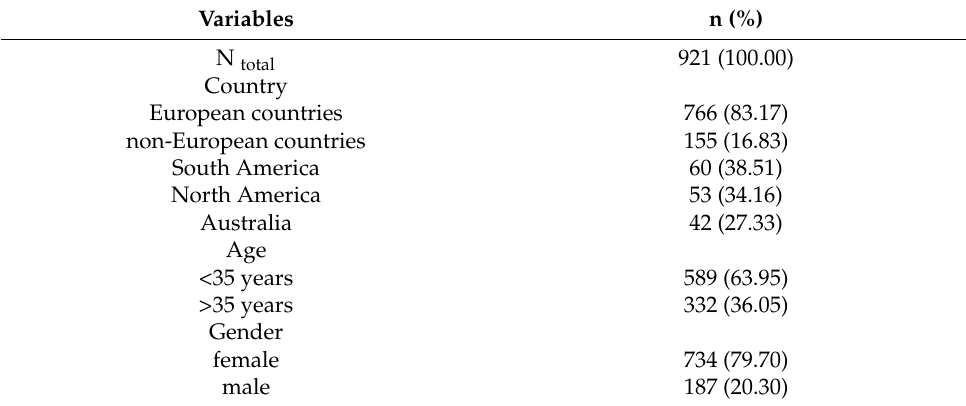
Table 1. General characteristics of the study population.